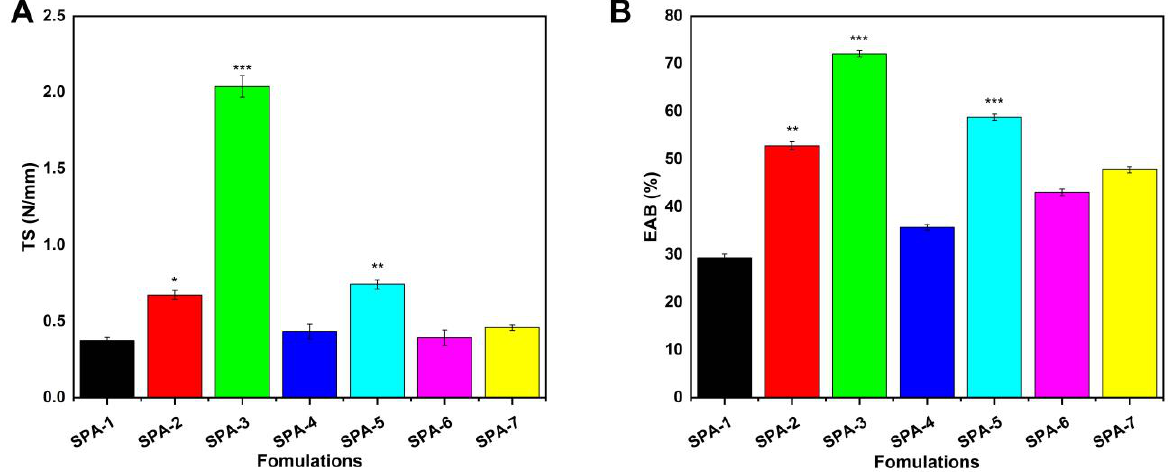
Figure 3. Mechanical properties of hydrogel membranes, such as tensile strength ( A ) and elongation at break ( B ). (Here, * represent p value < 0.05, ** p < 0.01, and *** p < 0.001).